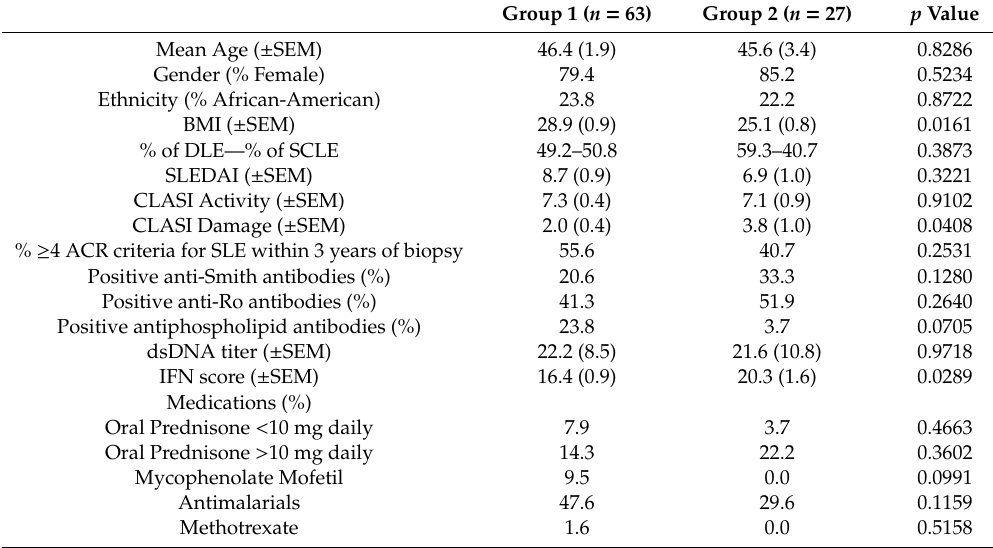
Table 4. Summary characteristics of lupus patients in each defined subgroup. Comparisons between the two subgroups were made using two-sided unpaired Students’ t